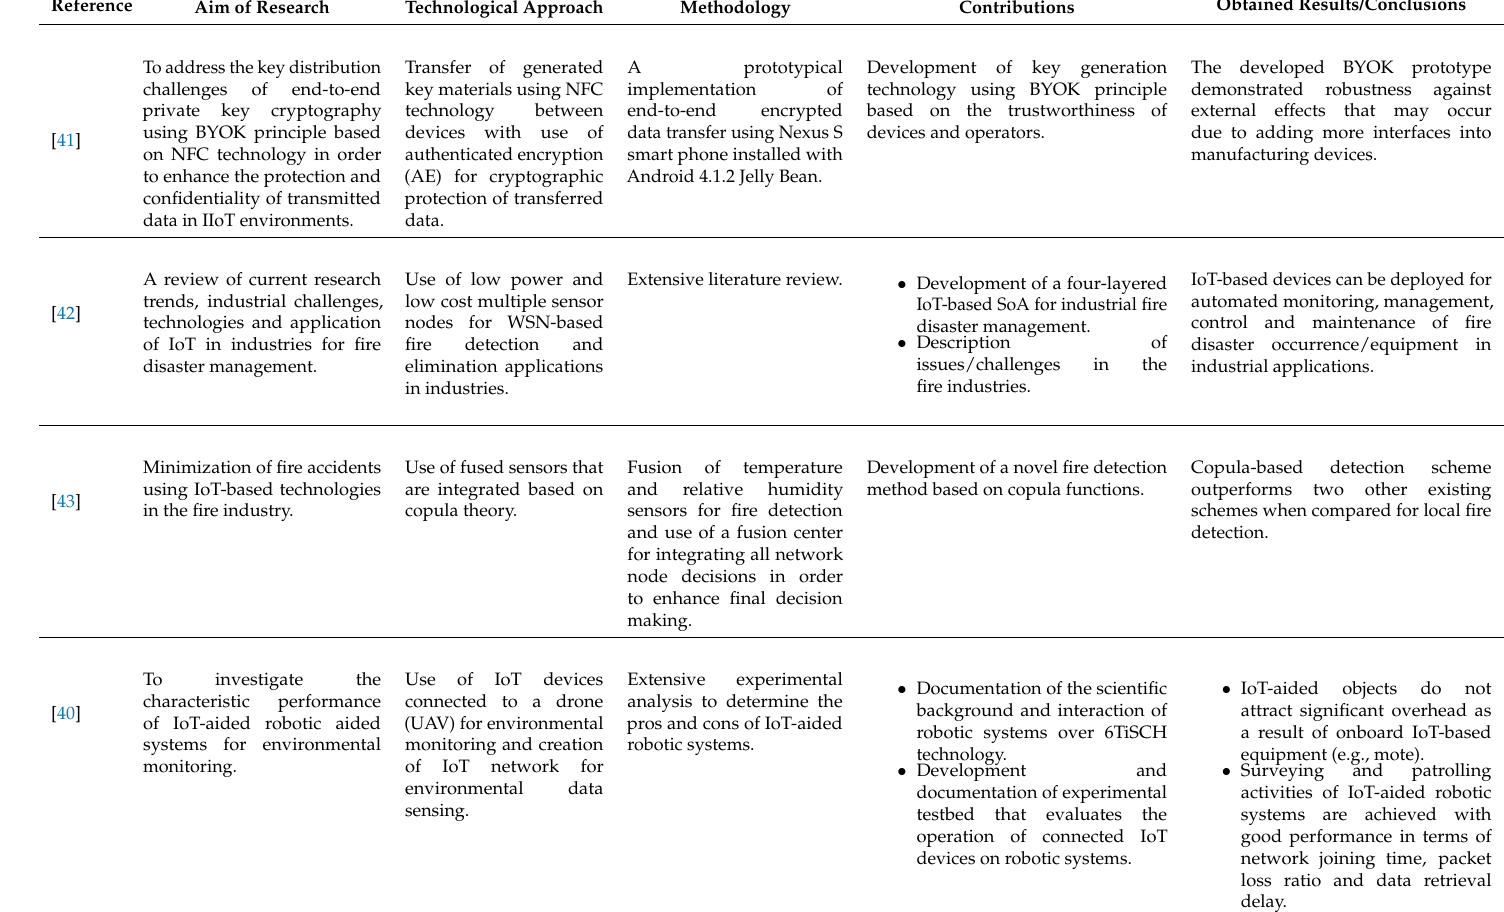
Table 1. Summary of research trends in the